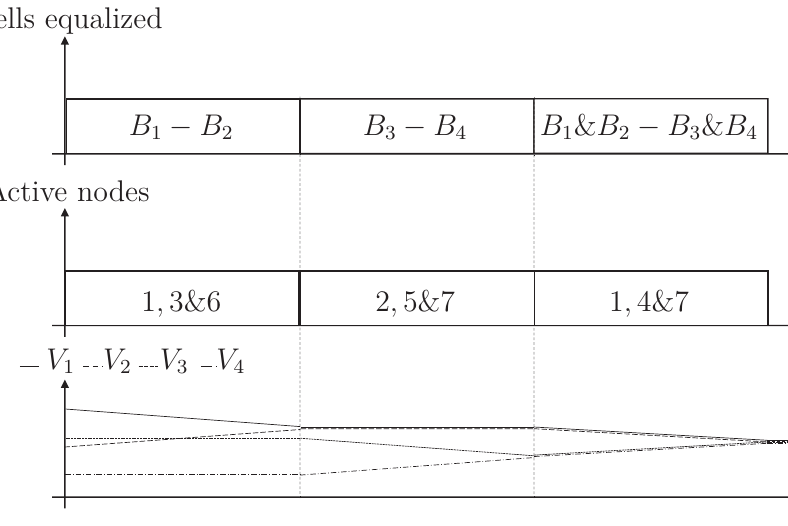
Figure 6. Waveform of the module of the switched-inductor topology.